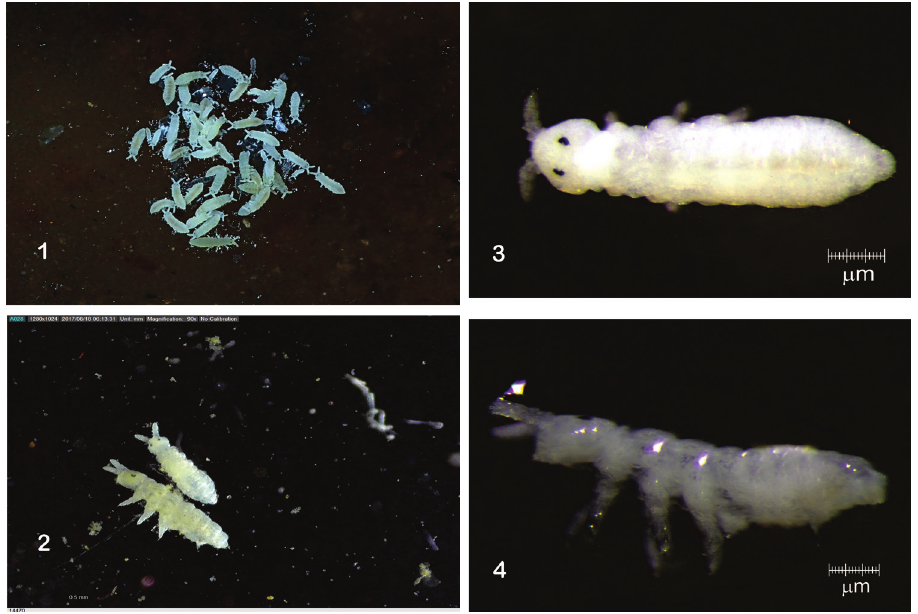
Figures 1–4. 1 Acheroxenylla lipsae sp. nov. 1, group of specimens floating on water close to the guano of oil birds 2 two specimens dorsal view just collected in ethanol 96%; photos 1 and 2 by Josiane Lips 3 dorsal view 4 lateral view, photos 3 and 4 by Maira Montejo and Angela Arango, scale in photos 3 and 4 is 150